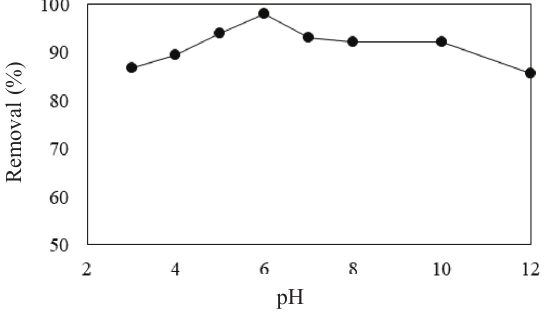
Fig. 3 – Effect of pH variation on removal efficiency of TC onto